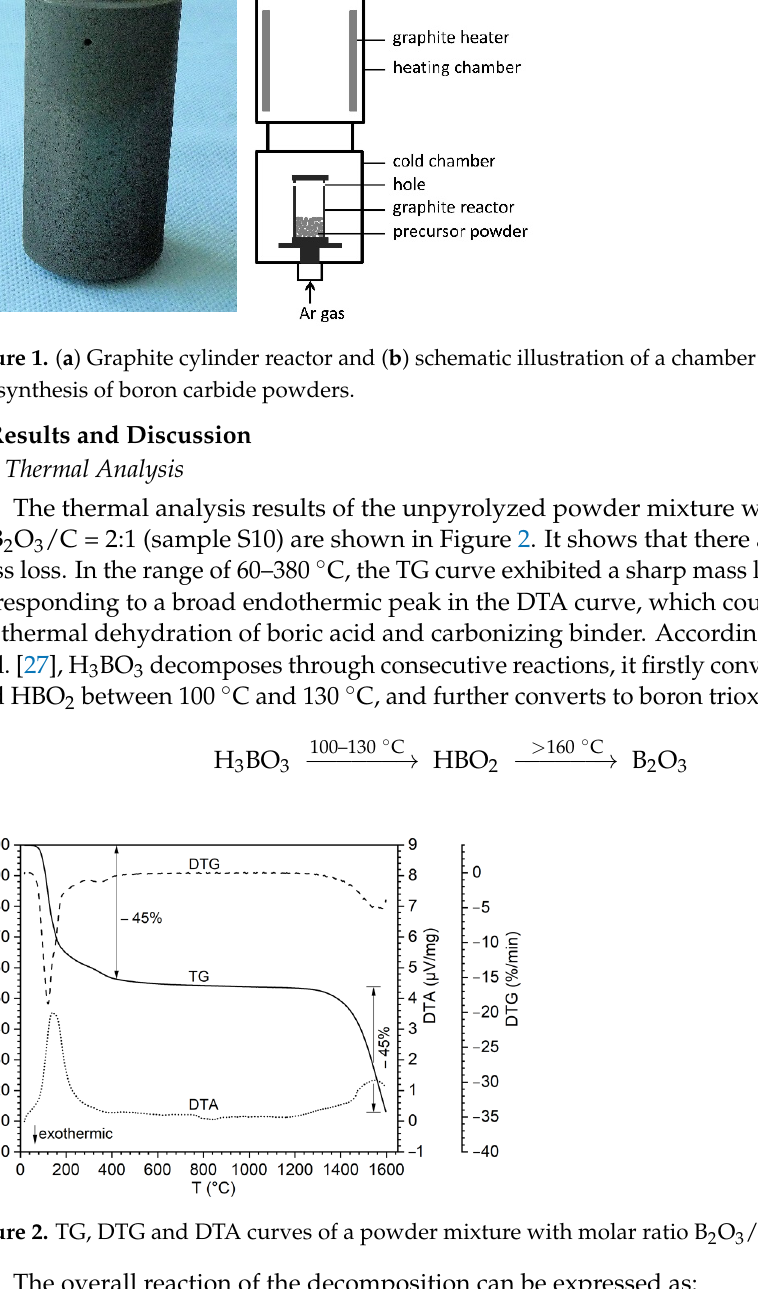
Figure 1. ( a ) Graphite cylinder reactor and ( b ) schematic illustration of a chamber furnace system for the synthesis of boron carbide powders.